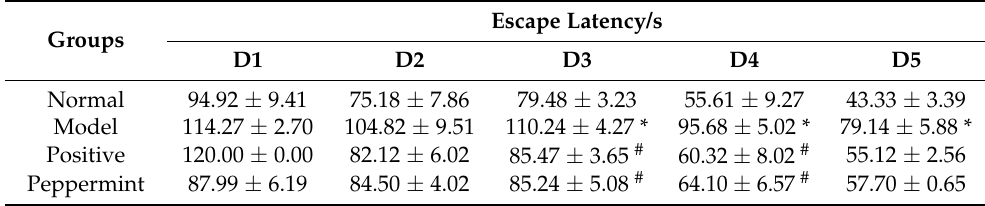
Table 1. Results of positioning cruise test (x ± S, n = 8).